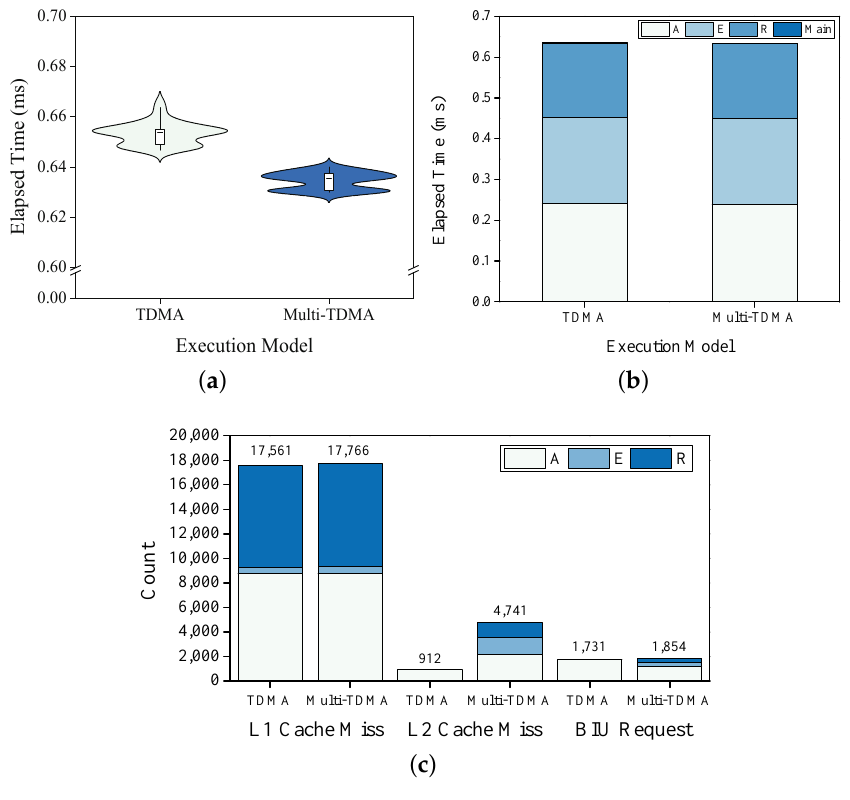
Figure 16. Benchmark measurement results by TDMA and multi-TDMA. ( a ) Execution time. ( b ) Execution time by each phase. ( c ) Cache miss and BIU